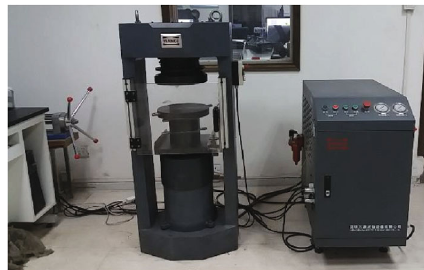
Figure 2: Rock mechanics test system.